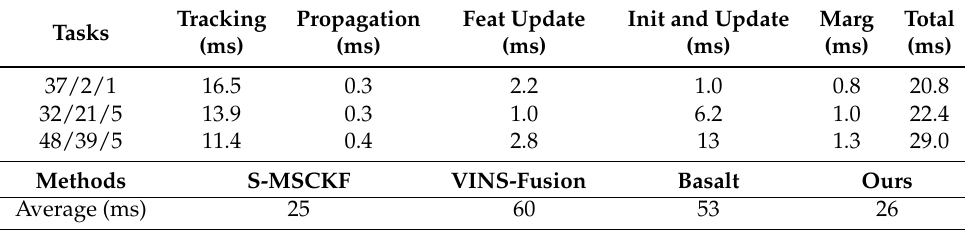
Table 2. A half table above indicates the processing time in milliseconds (ms) for each task in our method. The comparison with Vision-Aided Inertial Odometry (VIO) technicals is presented in a half table below. The numbers in the first column, such as 32/21/5, indicated 32 standard features, 21 SLAM features, and five Delay features treated. the Marg represents the marginalization process.